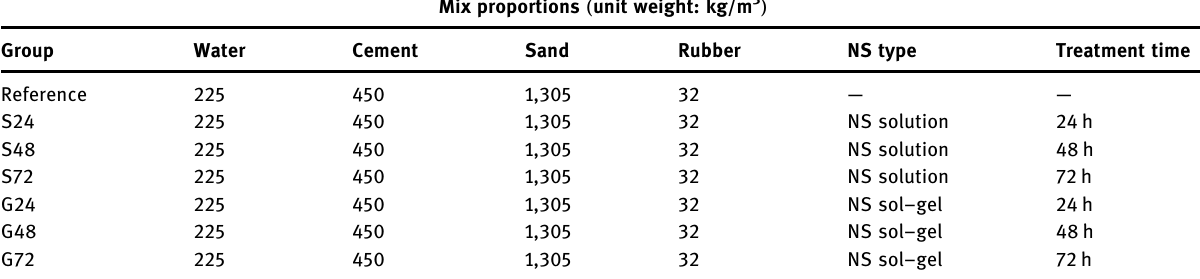
Mix proportions ( unit weight: kg/m 3 )